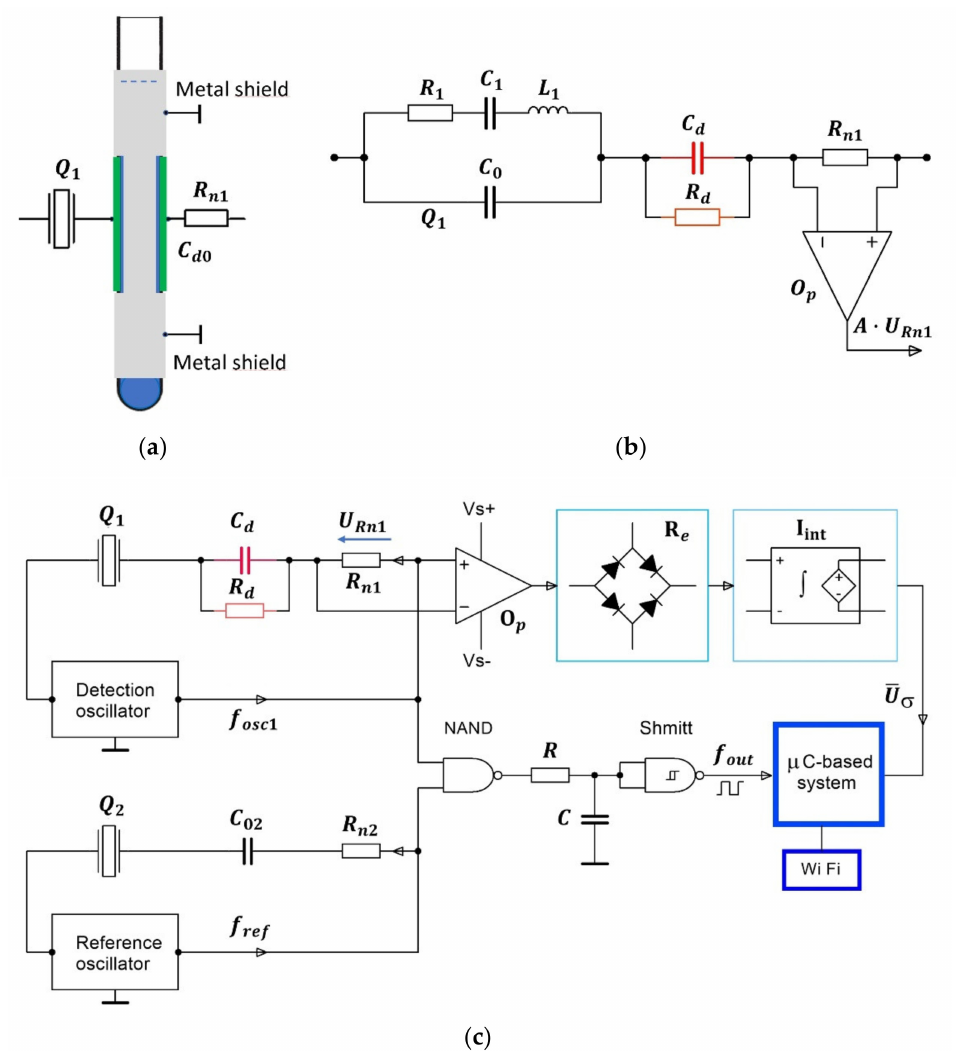
Figure 1. ( a ) The measuring part of the experimental setup: C d 0 is a capacitance of an empty glass tube, Q 1 is the quartz and R n 1 is a resistance of the series resistor. ( b ) A substitute electrical circuit from ( a ) with an operational amplifier added for the conductivity measurements. ( c ) Dielectric measurement principle by capacitive-dependent quartz crystal and two oscillators with similar crystal temperature–frequency